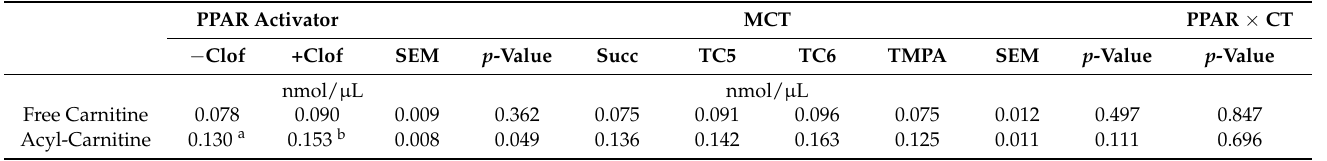
Table 1. The effect of clofibrate and MCTs on plasma